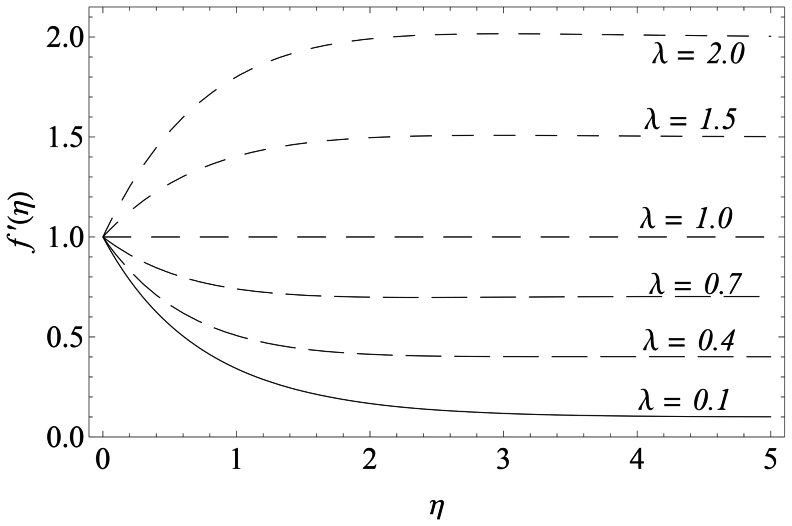
Influence of λ on .